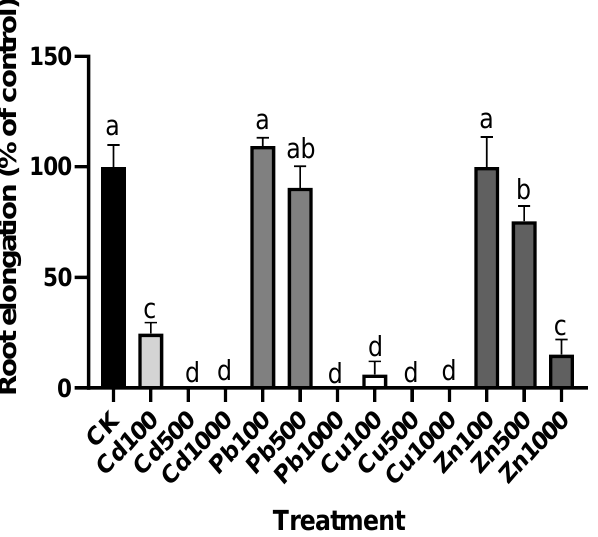
Figure 1. Root elongation (% of control) in roots of M. cordata under control (CK) and different concentrations of Cd, Pb, Cu, and Zn after 20 days of exposure. Values are means ± SEs ( n = 3) of three different experiments. Means denoted by different letters refer to the significant differences ( p < 0.05, Duncan’s test).